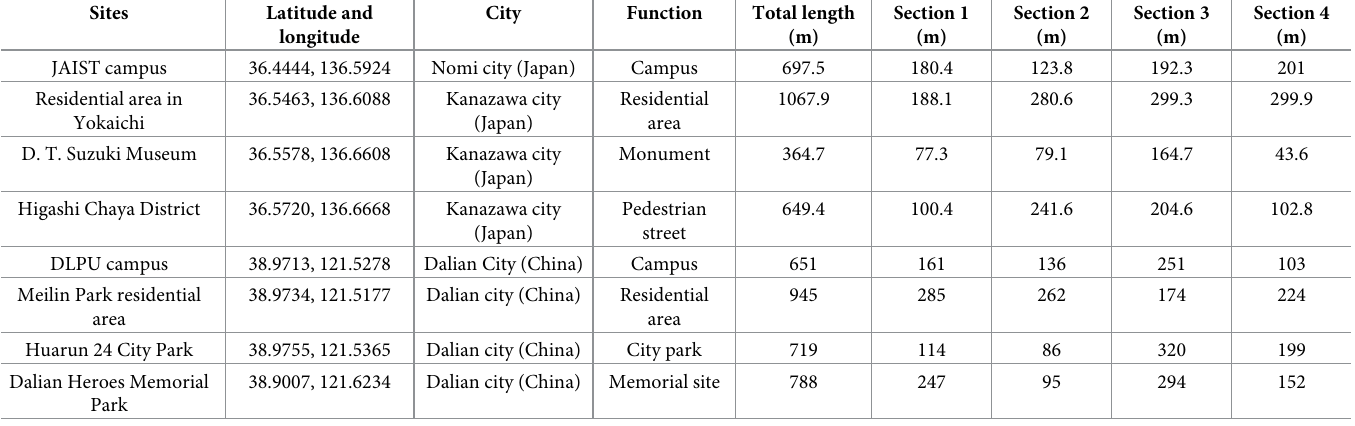
Table 2. Basic information on the eight spaces and their data were used for model training and testing. Sites Latitude and